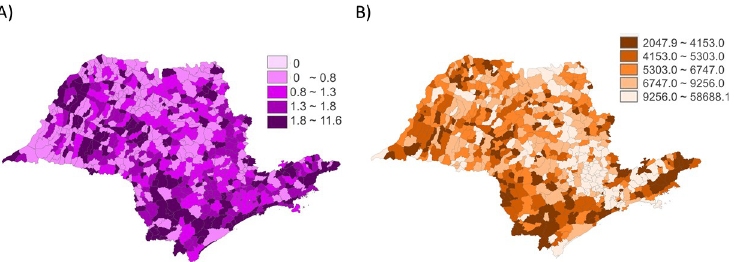
Fig 2. Neonatal asphyxia-associated mortality and mean per capita GDP crude rates. A) Raw rates of neonatal asphyxia-associated mortality classified by quintiles. Darker colors show municipalities with higher asphyxia- associated mortality rates. B) Raw rates of mean per capita GDP in US$, classified by quintiles. Darker colors show municipalities with lower mean per capita GDP. Data are presented for each 645 S ã o Paulo Municipalities (Brazil), from 2004 to 2013.